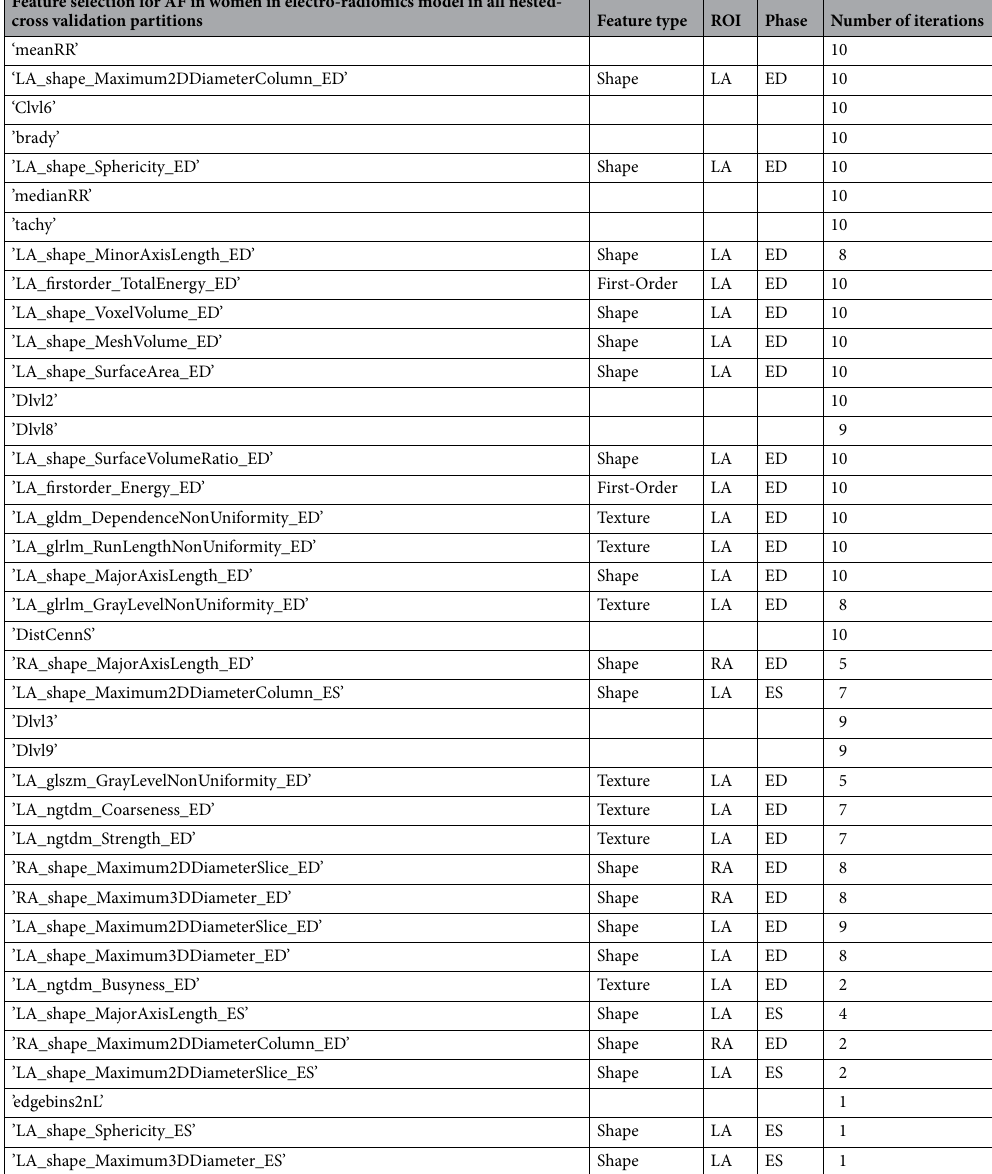
Table 5. Feature selection for AF for women for the electro-radiomics model in all partitions in the nested- cross validation indicating the number of repetitions in each feature in each different